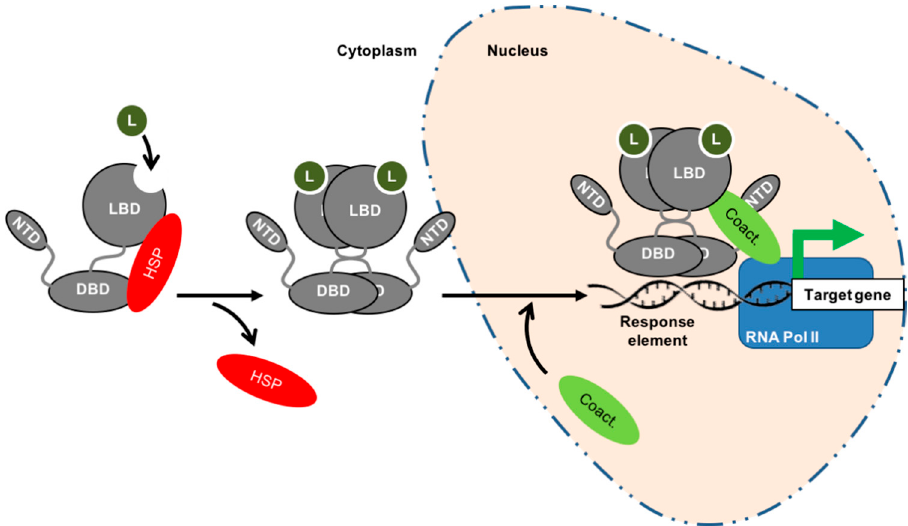
Figure 1. Schematic structure and functioning of steroid receptors. Nuclear receptors are composed of an N-terminal domain (NTD), a DNA-binding domain (DBD) responsible of the binding to the DNA-target sequences usually located within the promoters of the targets genes and a C-terminal ligand-binding domain (LBD), which is specific to the molecule. Canonically, it is admitted that steroid receptors are located within the cytoplasm in the absence of hormone, bound to heat shock proteins (HSP) that impede shuttling to the nucleus. The binding of the steroid (L) allows the chaperones to unbind from the receptor and migrate to the nucleus after a homodimerization. The binding of co-activators (Coact.) makes the recruitment of the transcriptional machinery possible, along with the RNA polymerase II (RNA Pol II), the transcription of the target gene, and the physiological effects. However, other types of NR, such as the liver X receptors (LXR α /NR1H3 and LXR β /NR1H), function in a heterodimer with retinoid X receptors (RXRs, the receptor for 9-cis retinoic acid, NR2B1-3). In such signaling systems, the heterodimer complex resides bound to DNA in the absence of a ligand, with transcription blocked by the presence of co-repressors (Figure